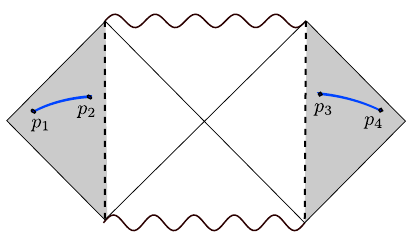
Figure 1. Penrose diagram of an eternal AdS 2 black hole with flat reservoirs glued to the bound- aries, and identical equal-time segments [ p of the union of these